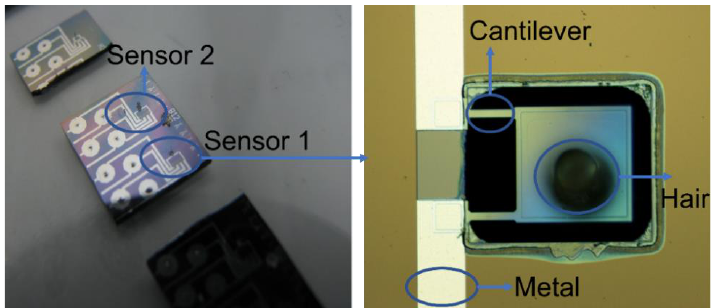
Figure 6. Volumetric flow sensor and a scanning electron micrograph of sensor 1.